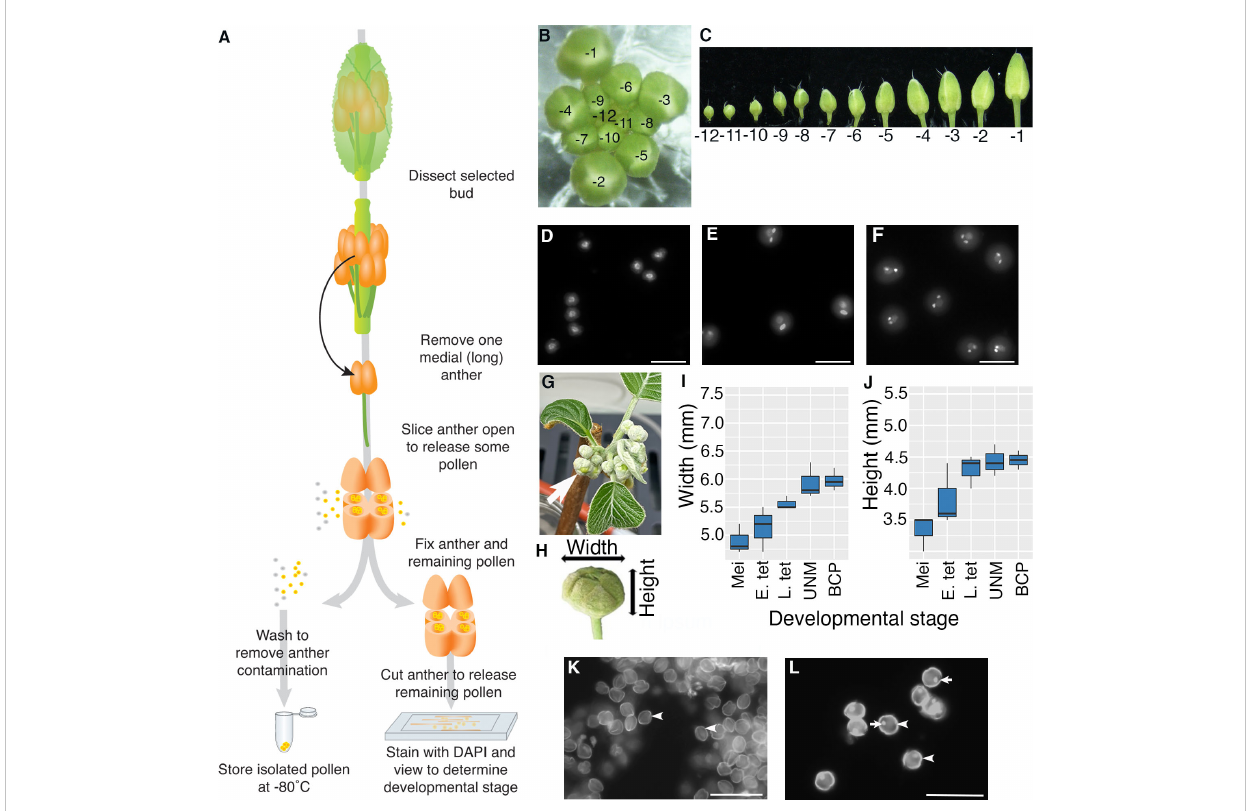
FIGURE 1 Isolation of pollen from a single anther. (A – F) Arabidopsis and (G – L) kiwifruit. (A) Flow diagram illustrating how pollen is isolated from a single anther from a bud from an Arabidopsis plant. A majority of the pollen is used for RNA-seq analysis (frozen), and the remaining pollen and anther material is used for determining the stage of pollen development. (B) An Arabidopsis in fl orescence with the relative age of buds indicated with -1 representing the bud closest to opening, the second unopened bud -2 etc. (C) Buds removed from an in fl orescence in order from the youngest bud dissected (-12) to the oldest unopened bud (-1). (D – F) Representative DAPI-stained pollen from Arabidopsis showing different stages of pollen development; uninucleate microspores after release from the tetrad with central nuclei (D) , pollen close to pollen mitosis II with a mix of late bicellular pollen with an elongated generative cell nucleus and some tricellular pollen (E) and tricellular pollen with two brightly stained sperm cells (F) . Images are not all from the same in fl orescence. Scale bars = 20 m m. (G) A kiwifruit node from a male plant with developing in fl orescences in an indoor growth facility. The node has several cymes each with a terminal fl ower (arrow) and lateral buds. (H) An isolated terminal bud from a kiwifruit in fl orescence indicating the width and height. (I, J) Terminal buds removed from kiwifruit nodes were measured for width (I) and height (J) before pollen mother cells/pollen were removed to determine the developmental stage. Box and whisker plots show the median and interquartile range of 10 buds for each developmental stage. Mei: meiotic cells; E. tet, early tetrads; L. tet, late tetrads; UNM, uninucleate microspores; BCP, bicellular pollen (K, L) Representative DAPI-stained pollen from kiwifruit; uninucleate microspores after release from the tetrad with the microspore wall showing bright auto fl uorescence (arrowhead) (K) and bicellular pollen with wall auto fl uorescence (arrowhead) a brightly stained generative cell (arrow) (L) . In kiwifruit pollen the microspore (UNM) and vegetative cell (BCP) nuclei are weakly stained by DAPI and cannot be easily seen. Scale bars = 500 m